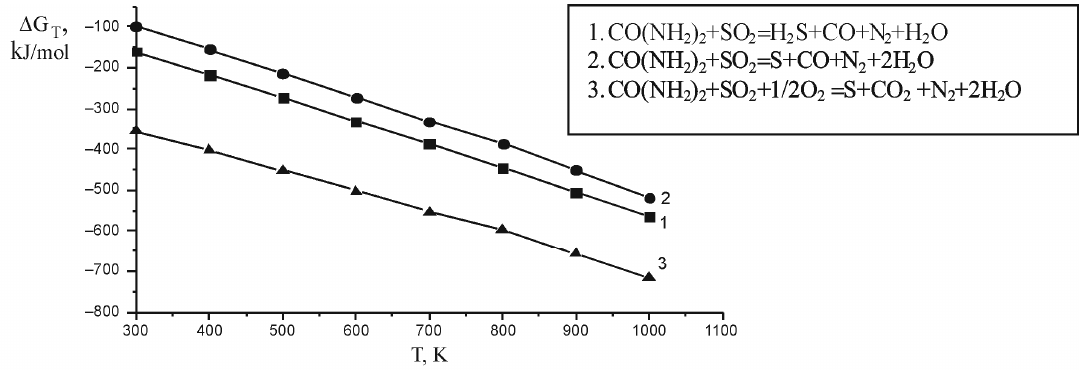
Fig. 5. The Gibbs’ energy value change dependency on temperature during reaction between carbamide and SO 2 according to the equations presented in the diagram